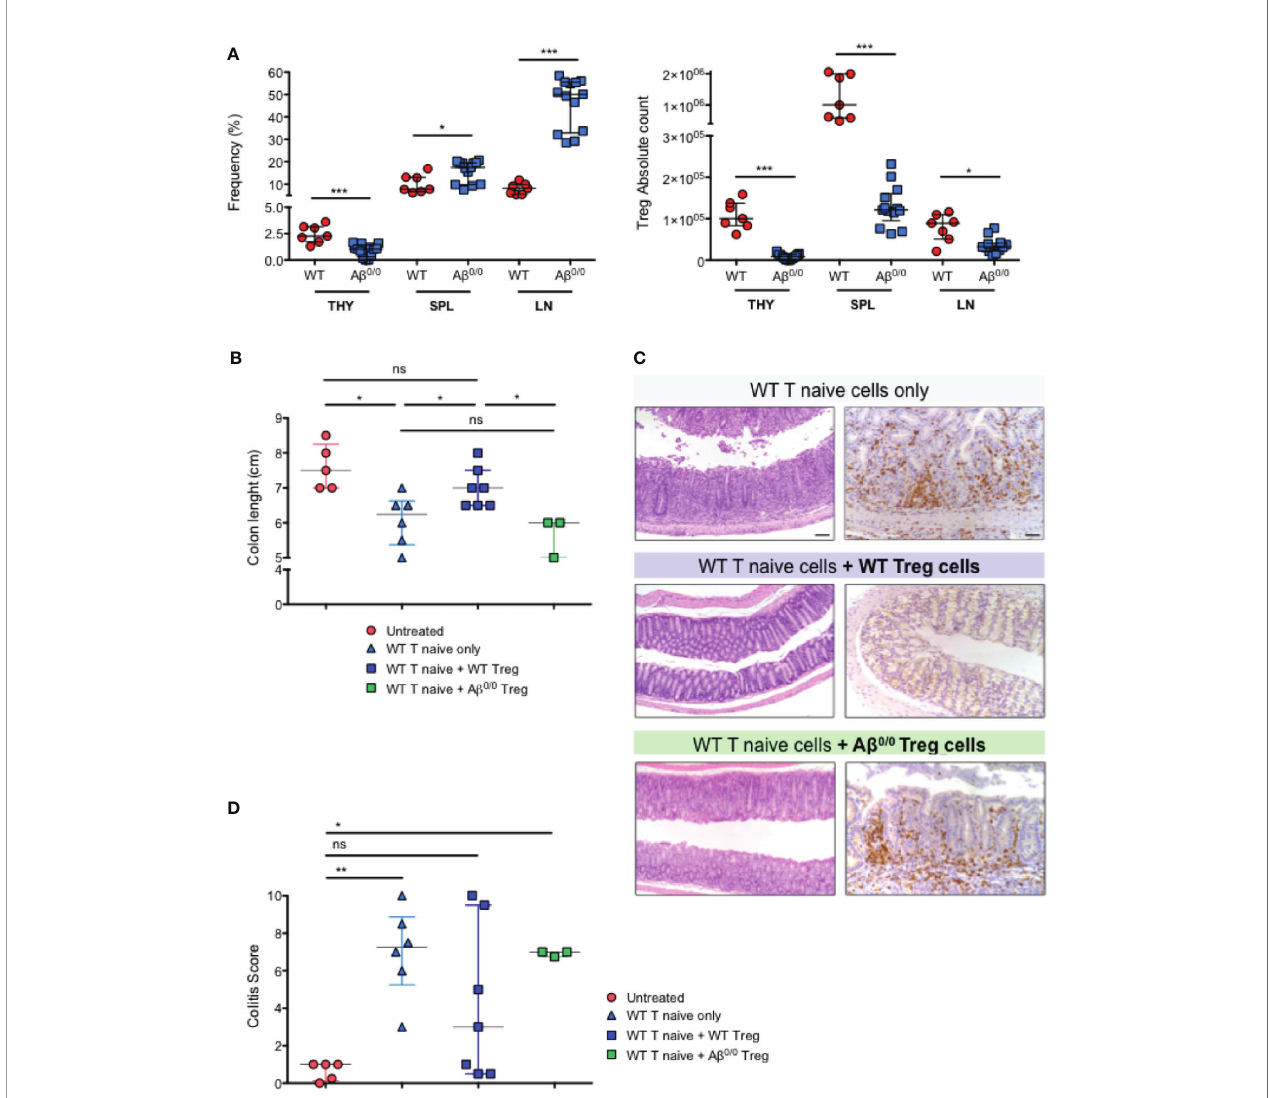
FIGURE 6 | Peripheral tolerance impairment in A b 0/0 mice. (A) Frequency and absolute count of Treg cells in WT and A b 0/0 mice. (Left panel) Frequency of Treg cells is expressed as the percentage (%) of FoxP3 + CD25 hi cells gated on CD4 + T-cell gate. (Right panel) Absolute count of Treg cells. THY, thymocytes; SPL, spleen; LN, lymph nodes. *p-value < 0.05; ***p-value < 0.001. (B) Colon length in the different treatment groups of induced colitis experiments. The graph shows the colon length of n = 3 – 7 mice/group from three experiments. Median score is reported for each treatment group. Error bars represent interquartile range. *p-value < 0.05; ns, not signi fi cant. (C) Histological analysis of the colon of treated mice. Representative colonic sections from Rag1 ko mice who received administration of WT T cells alone or in combination with WT or A b 0/0 Treg cells, stained with H&E ( left panels ) and CD3 immunostaining ( right panels ). Original magni fi cations: 10× for H&E, 20× for CD3 staining. (D) Colitis score in the different treatment groups of induced colitis experiments. The graph shows the in fl ammation score in the gut of n = 3 – mice/group from three experiments. Median score is reported for each treatment group. Error bars represent interquartile range. *p-value < 0.05; **p-value < 0.01; ns, not signi fi